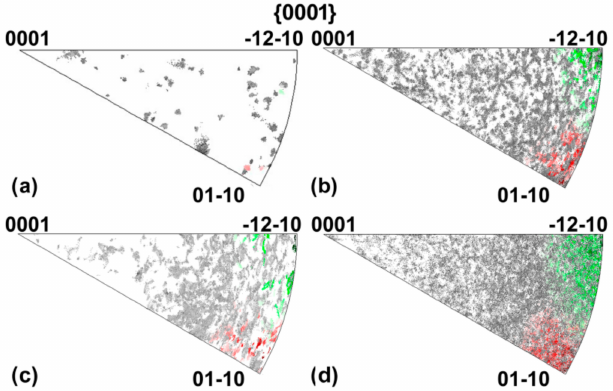
Figure 5. Inverse Pole Figures for samples: RS-ST ( a ); RS + 400 RPM FSP ( b ); RS + 800 RPM FSP ( c ); RS + 1200 RPM FSP ( d ). Orientation {0001} < 10-10 > depicted in red, orientation {0001} < 11-20 > depicted in green.